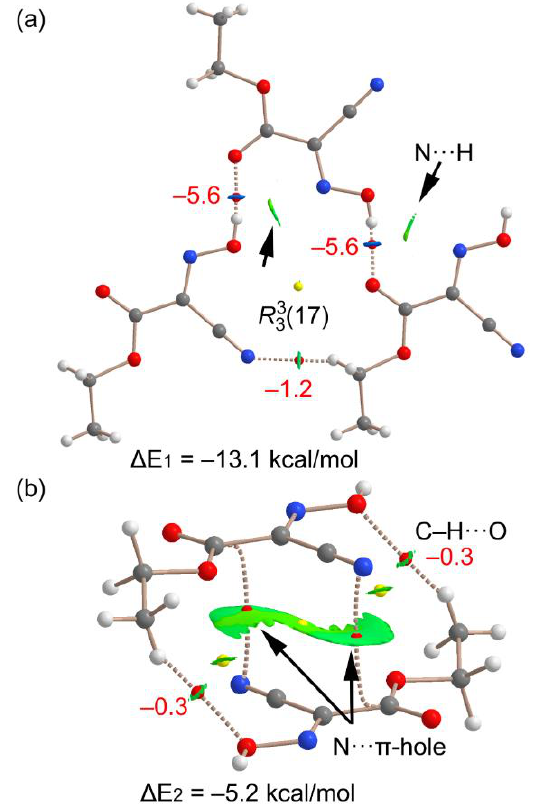
Figure 5. QTAIM/NCIPlot analysis of the H-bond trimer ( a ) and π -hole dimer of Oxyma ( b ). The bond CPs are represented as red spheres and bond paths as dashed lines. Only intermolecular CPs bond paths and RDG isosurfaces are shown.